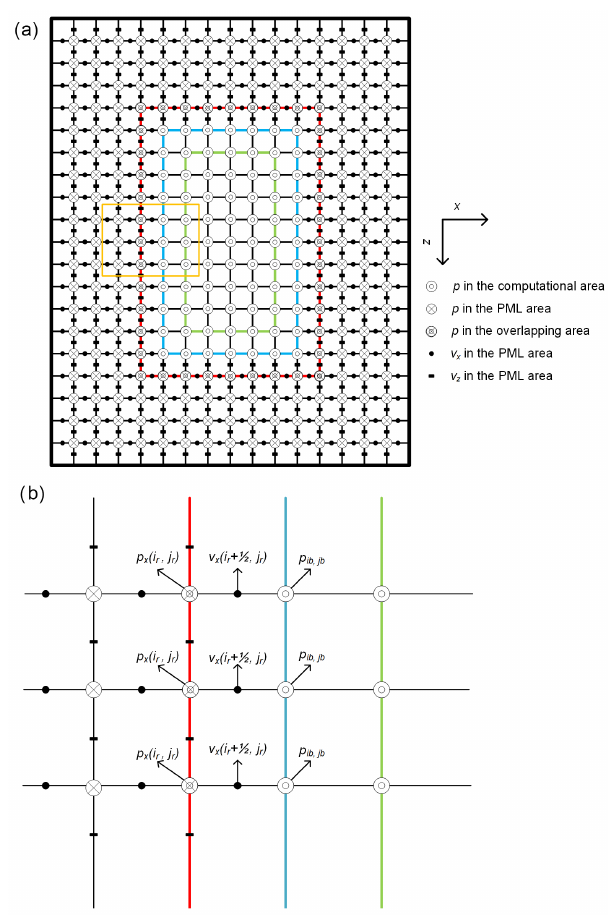
Figure 1. Schematic of our method: (a) the entire region and (b) partial enlargement of the yellow rectangle in panel (a) .